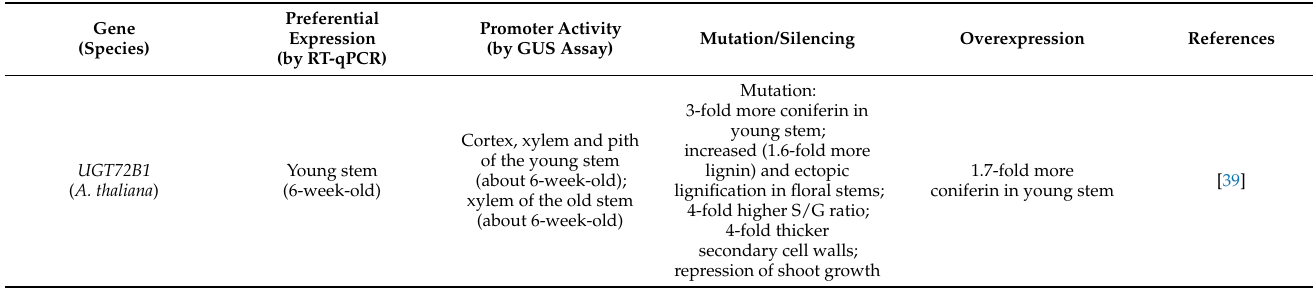
Table 3. Gene expression profile and functional characterization of UGT72 s associated with monolig- nol glycosylation. ns: not studied./: no phenotype